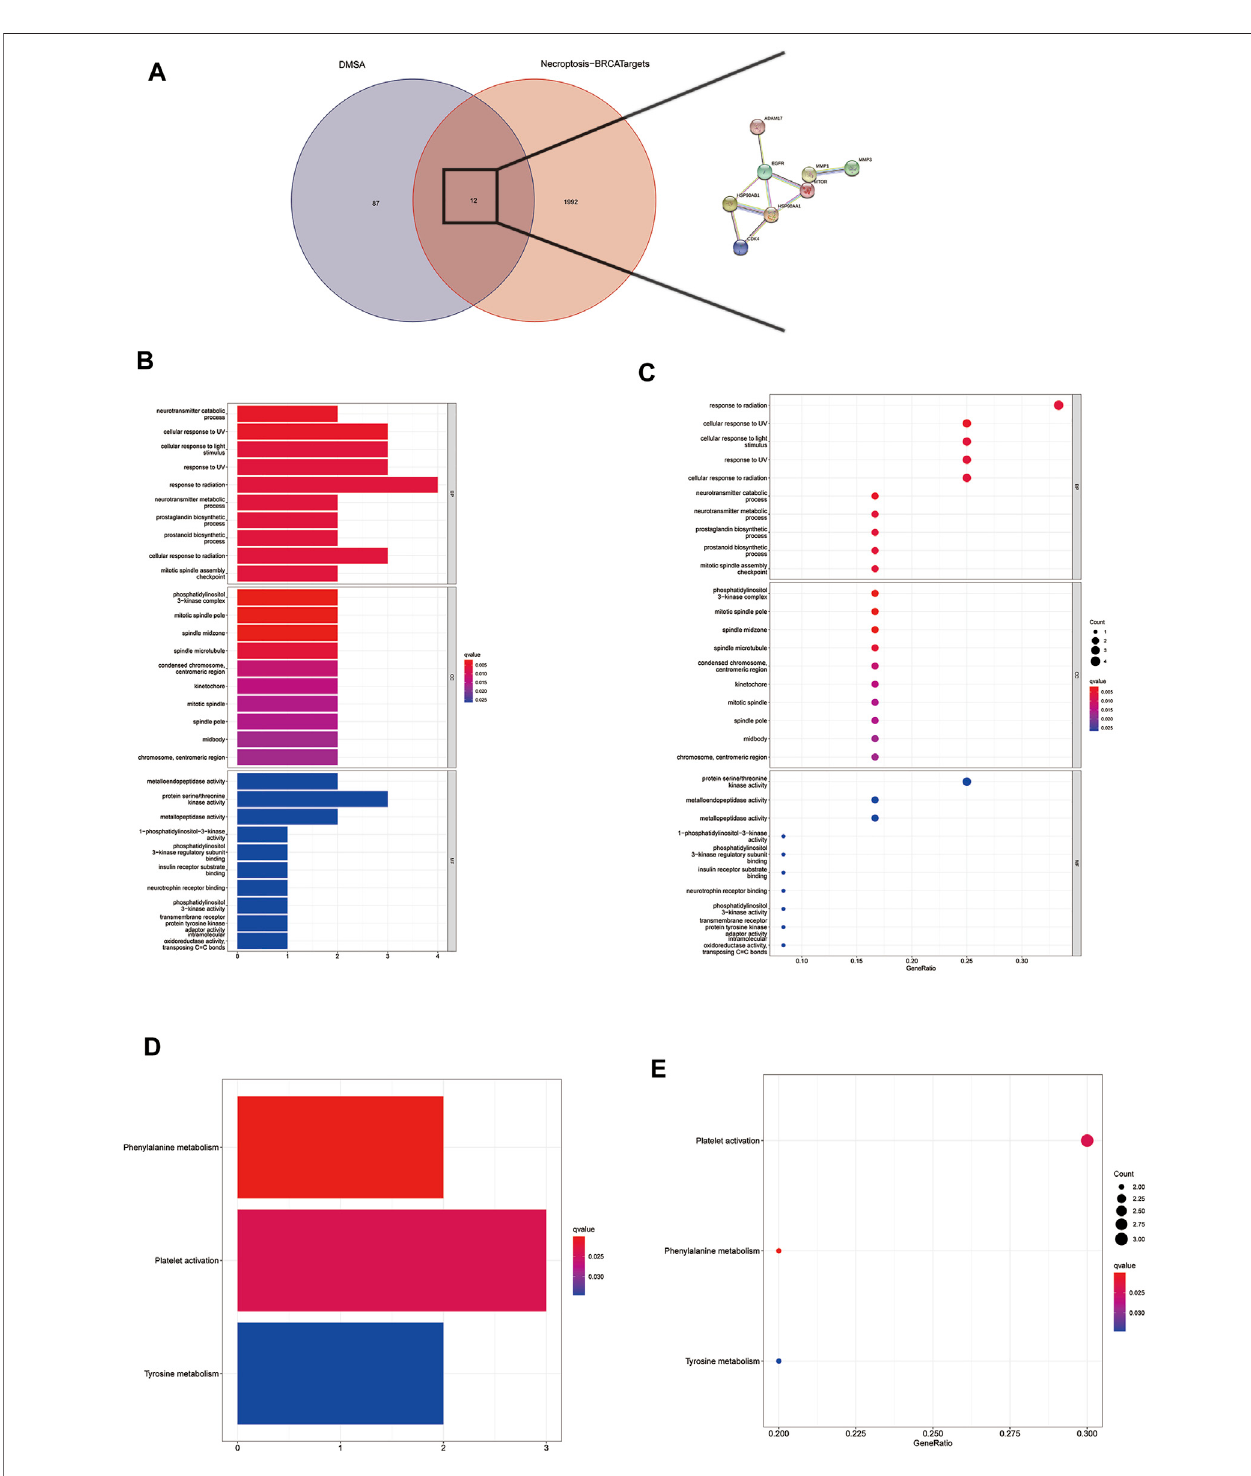
FIGURE 8 | Screening for intersecting genes of drug targets and differentially expressed genes (A) . The top 30 signi fi cant terms of GO function enrichment. BP biological process, CC cellular component, MF molecular function (B,C) . The all signi fi cant terms of KEGG analysis (E,F) .